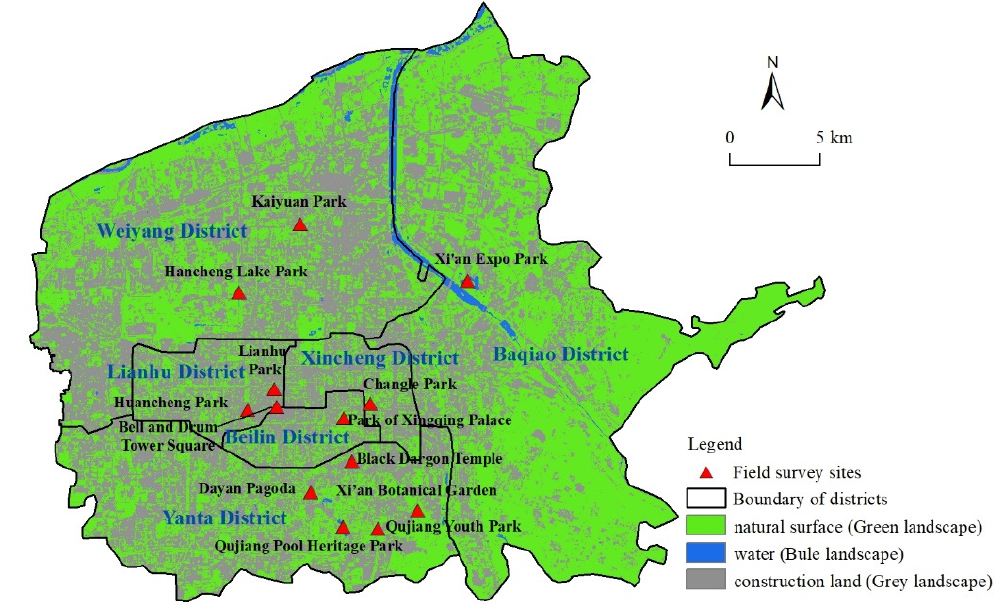
Figure 1. Study area and field survey sites.